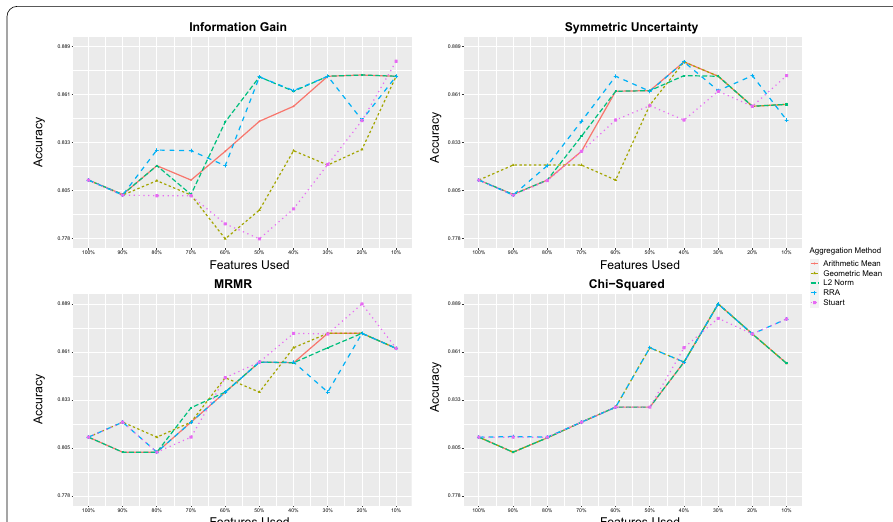
Fig. 8 Ionosphere dataset classification results